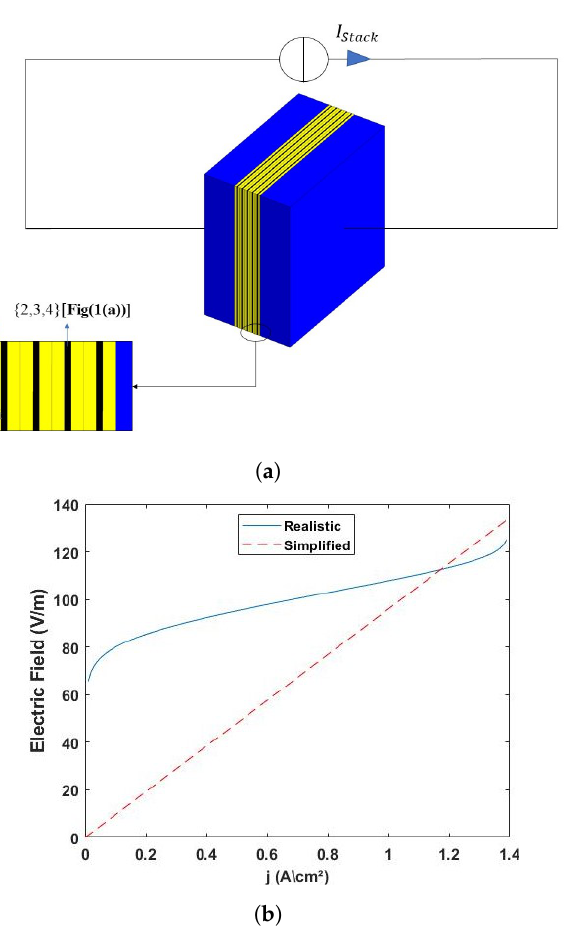
Figure 5. (a) Equivalent electric circuit of the passivized FC, (b) Membrane electric field characteristics Figure 5. ( a ) Equivalent electric circuit of the passivized FC, ( b ) membrane electric field characteristics of the realistic and simplified emulator of the realistic and simplified